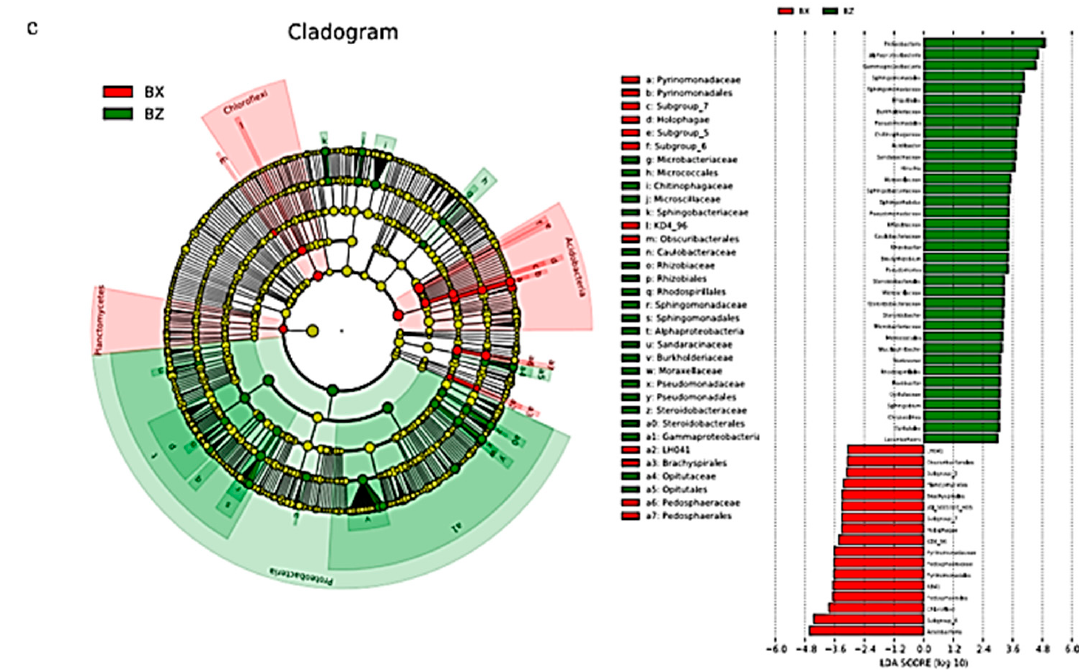
Figure 4. Bacterial linear discriminant effect size (LEfSe) analysis of litter layers. Cluster tree of bacterial LEfSe analysis in ( a ) Korean pine plantation and original Korean pine forest, ( b ) different litter layers in Korean pine plantation, and ( c ) different litter layers of original Korean pine forest.